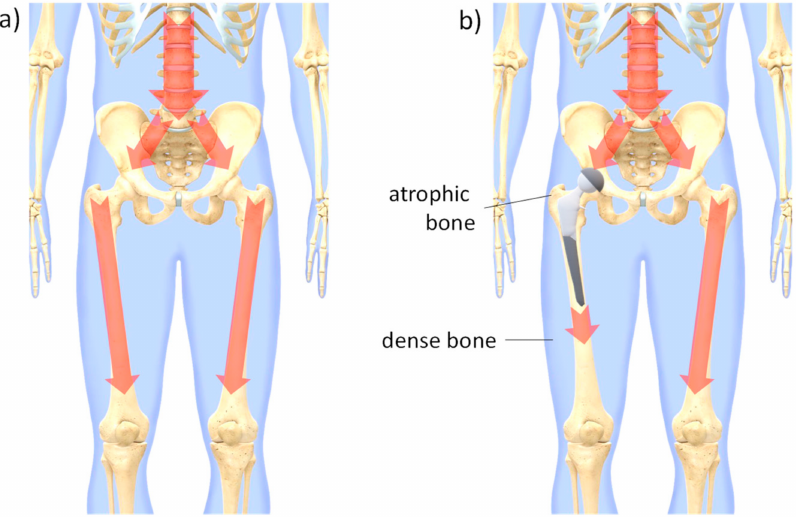
Figure 3. Physiological distribution of the load ( a ) and altered distribution of the load due to the insertion of a hip prosthesis ( b